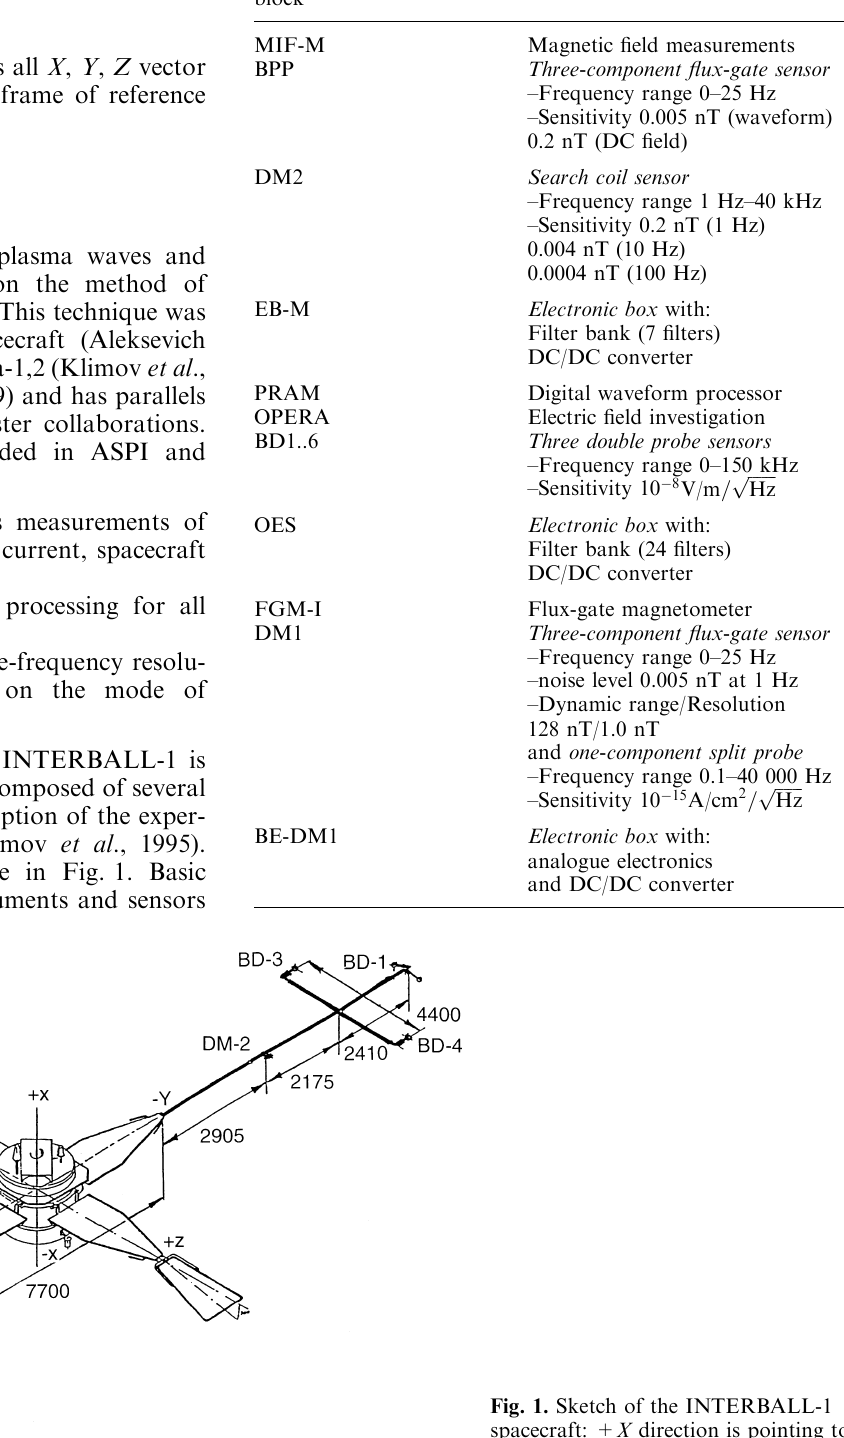
Fig. 1. Sketch of the INTERBALL-1 spacecraft: + X direction is pointing to the Sun; dimensions are in mm. ASPI sensors are shown